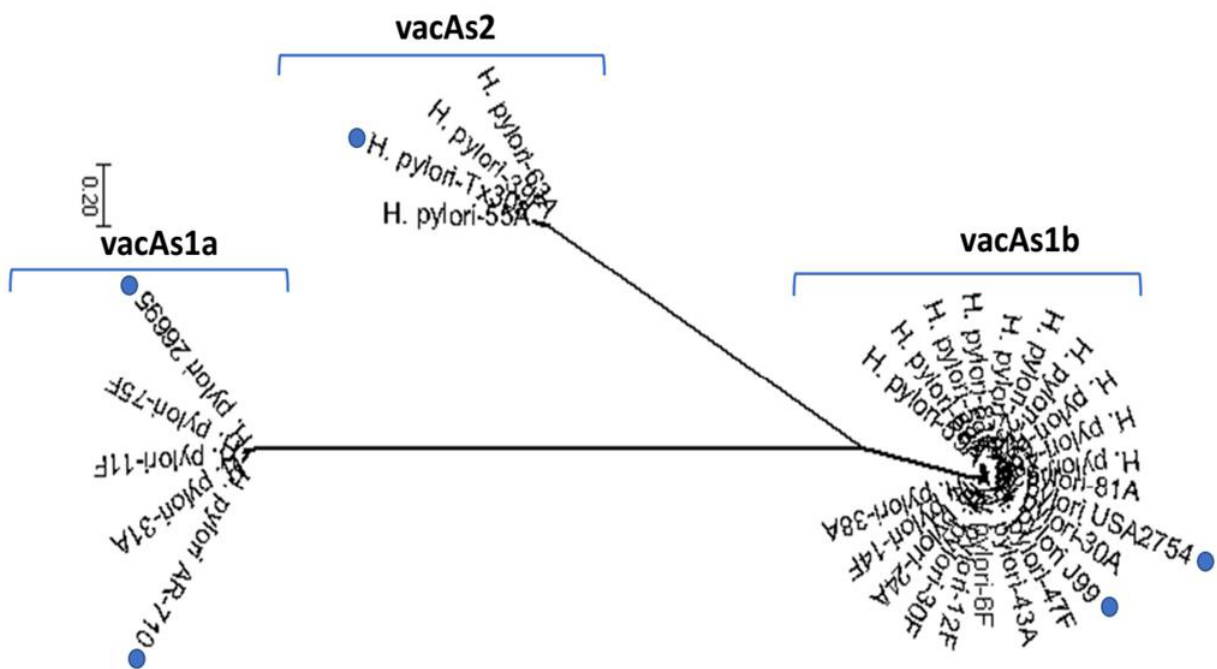
Figure 2. Phylogenetic tree of Navajo vacA s alleles in Helicobacter pylori sequences. The vacA s1a alleles are shown on the left with two typical vacA s1a strains (26695-NC_000915.1:938415-942287 and AR-710-AY185128.1). Sequences shown on the right display vacA s1b alleles with reference strains (USA2754-AB057223.1, 60190-U05676.1 and J99-NC 000921.1). The vacA s2 allele is shown on the